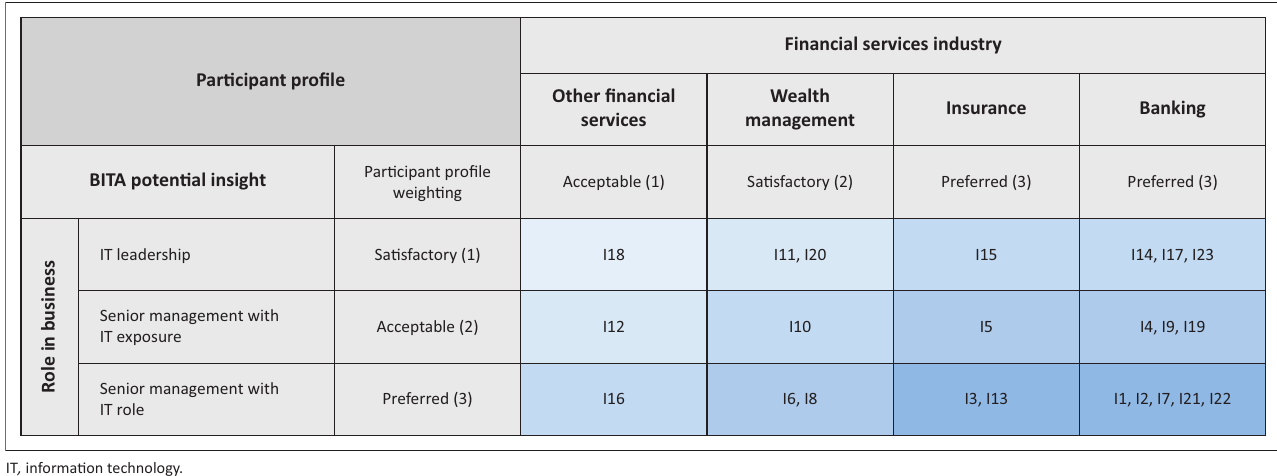
FIGURE 1: Final list of